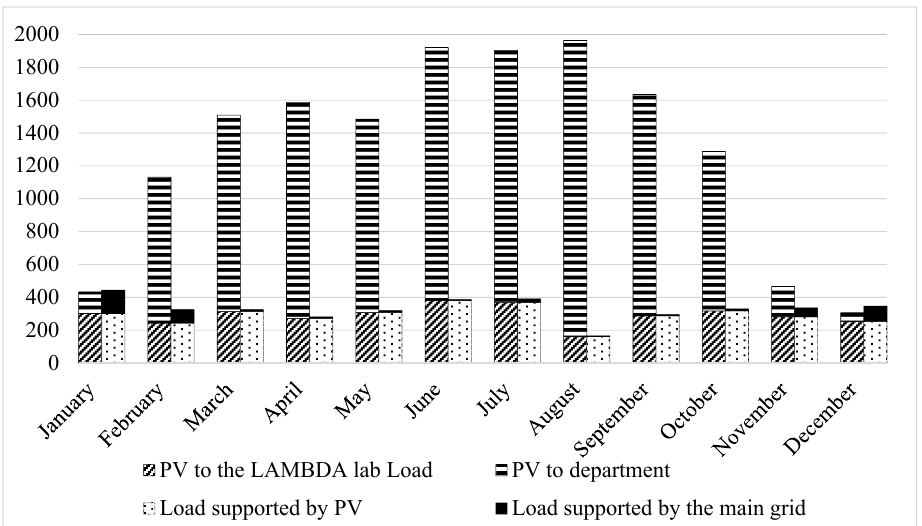
Figure 16. The summarized energy behavior in kWh for the LAMBDA MG testbed in 2019.